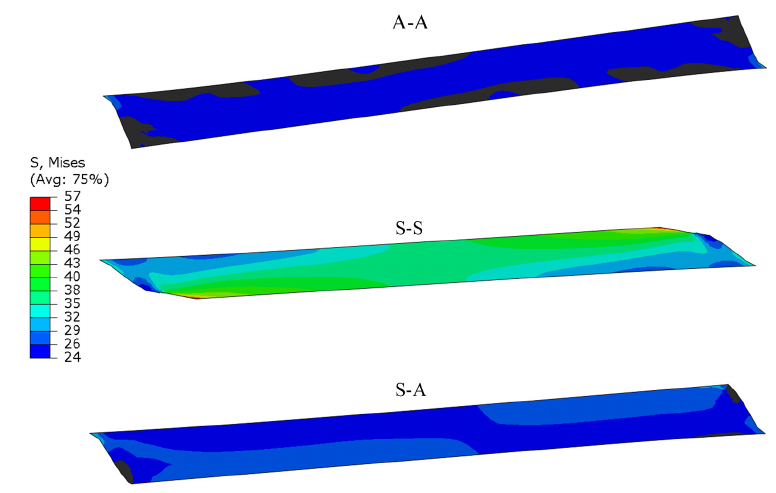
Figure 21. Map of the adhesive layer reduced stress, according to von Mises hypothesis.